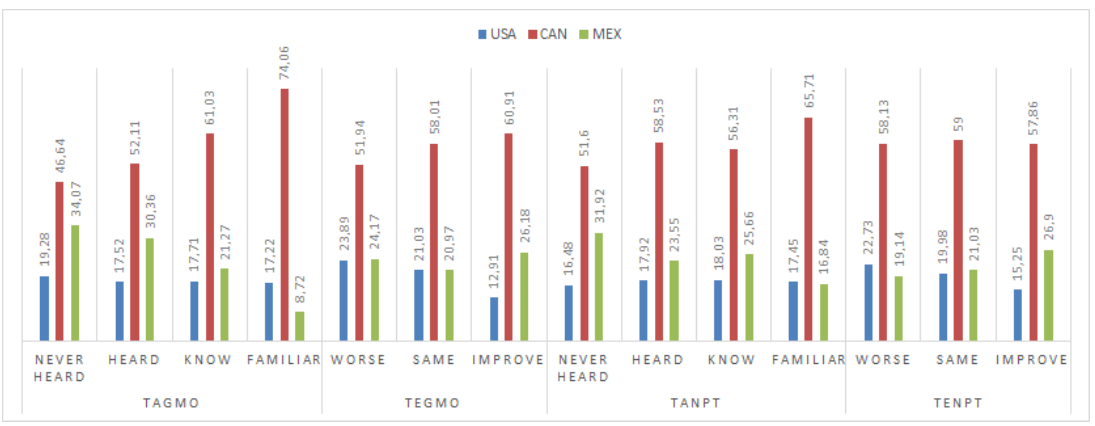
Figure 4. Conditional percent relative frequencies of youth technological awareness and expectations by